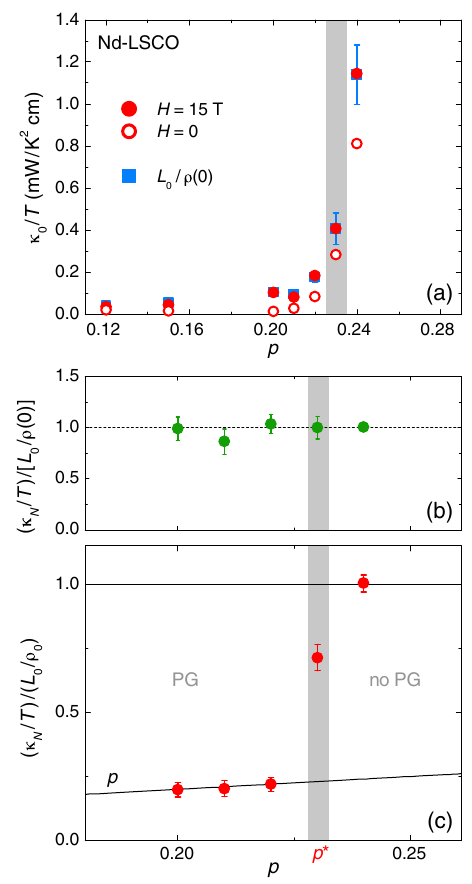
FIG. 4. (a) κ 0 =T in Nd-LSCO at H ¼ 0 (open red circles) and 15 T (red dots), and L 0 = ρ ð 0 Þ at H ¼ 15 T (blue squares), as a function of doping. The error bars on L 0 = ρ ð 0 Þ come from the geometric factor error, (cid:2) 10% , and the uncertainty on estimating ρ ð 0 Þ , (cid:2) 5 μ Ω cm ( (cid:2) 0 . 5 μ Ω cm for p ¼ 0 . 24 ). The error bar on κ 0 =T is (cid:2) 0 . 01 mW = K 2 cm, which is smaller than the symbols. (b) Ratio ð κ N =T Þ = ½ L 0 = ρ ð 0 Þ(cid:4) as a function of doping, where κ N =T is the normal state κ 0 =T , measured at H ¼ 15 T. (c) Ratio ð κ =T Þ = ð L = ρ Þ as a function of doping, N 0 0 where ρ 0 is proportional to the level of disorder in each sample (see text). In panels (b) and (c), the error bars come from the uncertainty on ρ ð 0 Þ , estimated to be (cid:2) 5 μ Ω cm ( (cid:2) 0 . 5 μ Ω cm for p ¼ 0 . 24 ), on ρ 0 , estimated to be (cid:2) 2 μ Ω cm ( (cid:2) 0 . 5 μ Ω cm for p ¼ 0 . 24 ), and the error on κ 0 =T as in (a). The gray vertical band in all panels gives the position of p ⋆ . The lower black line in (c) is equal to p , showing that the normal-state conductivity of the pseudogap phase (PG) at T ¼ 0 is only a fraction ∼ p of its value just above p ⋆